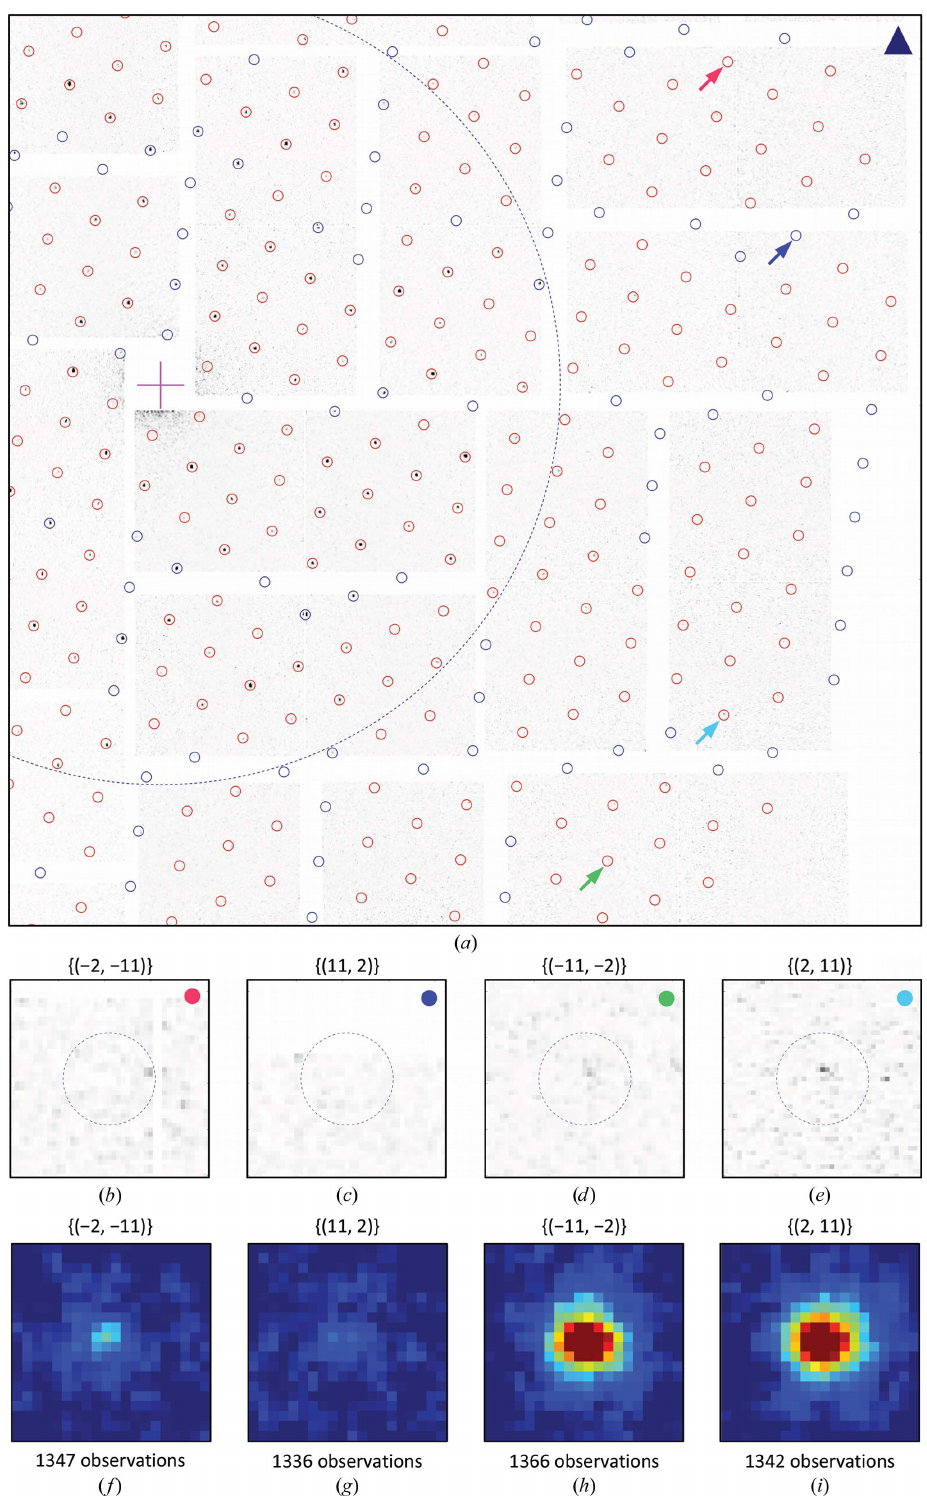
Figure 9 High-resolution data. ( a ) Extension to high resolution of the diffraction image in Figs. 3( a ) and 4( a ), in which a single lattice was identified. The circles mark the predicted peak positions to 4 A˚ in-plane resolution. Red circles are valid positions on the detector, while blue circles are invalid positions owing to module gaps or masked pixels. The dashed blue circle corresponds to 7 A˚ in-plane resolution. The magenta cross represents the direct-beam position. ( b )–( e ) Magnifications at the peak positions labelled in ( a ) by an arrow of the corresponding colour. The four reflections are labelled by the indices of the corresponding p 3 reflection {( h , k )} and have the same in-plane resolution of 4.46 A˚ . ( f )–( i ) Image-sector sums of the four reflections. The number of observations N is Cecilia M. Casadei et al. (cid:2) SFX of two-dimensional membrane-protein crystals